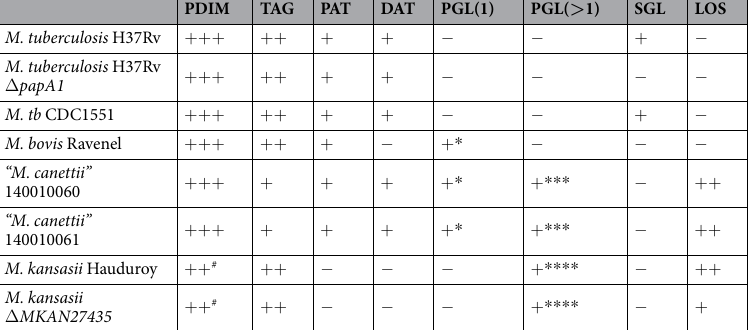
Table S1. The two M. tuberculosis strains absorbed the most dye, with CDC 1551 being the strongest. The H37Rv Δ papA1 mutant significantly took up less dye than the parent strain and M. bovis Ravenel had lower dye uptake than M. tuberculosis . As indicated previously 3, 15 , the two strains of “ M. canettii ” absorbed much less dye than the M. tuberculosis representatives. The dye absorbed by M. kansasii was reduced in comparison with the “ M. canettii” strains, but the Δ MKAN27435 partially LOS-deficient mutant appeared to absorb more dye than the parent. The statistically significant reduced Congo Red uptake of the H37Rv Δ papA1 mutant (Fig. 3a) could be correlated with loss of sulfoglycolipid (SGL) (Table 1, Supplementary Fig. S2), with its extremely hydrophobic phthioceranate and hydroxyphthioceranic fatty acids 3 . Conversely, diminished hydrophilic LOS content (Table 1,